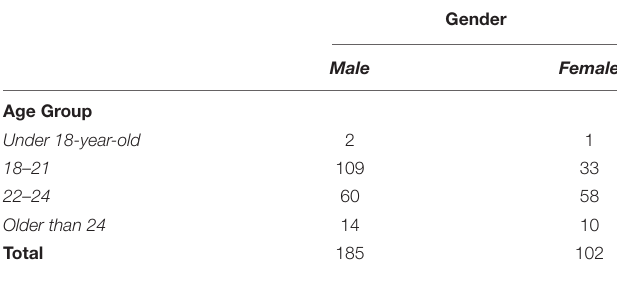
TABLE 1 | Demographic characteristics of the study